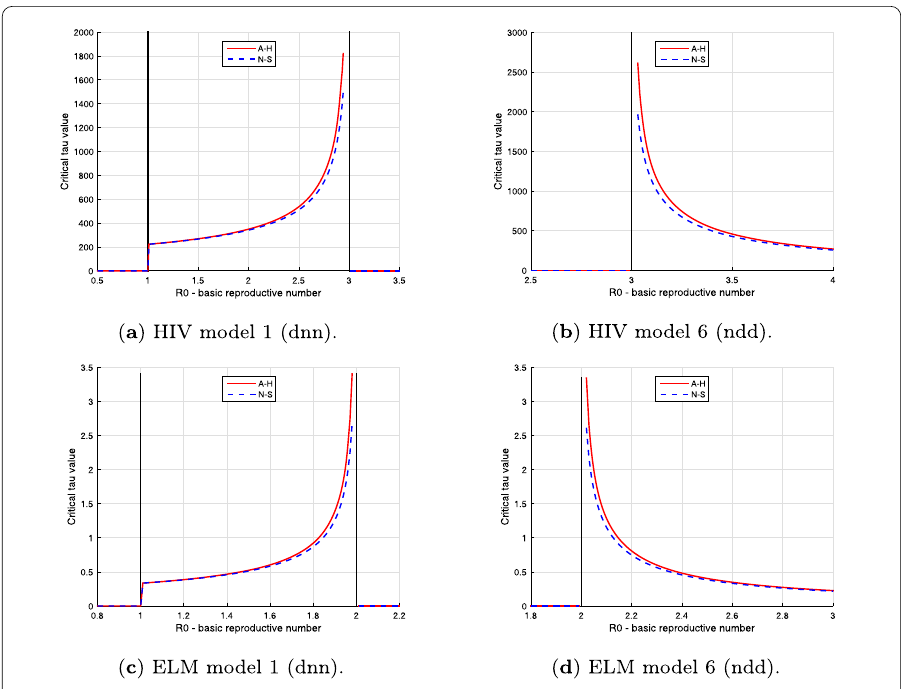
Figure 7 Plots of critical delays τ c vs basic reproductive numbers R 0 for HIV and ELM versions 1 and 6